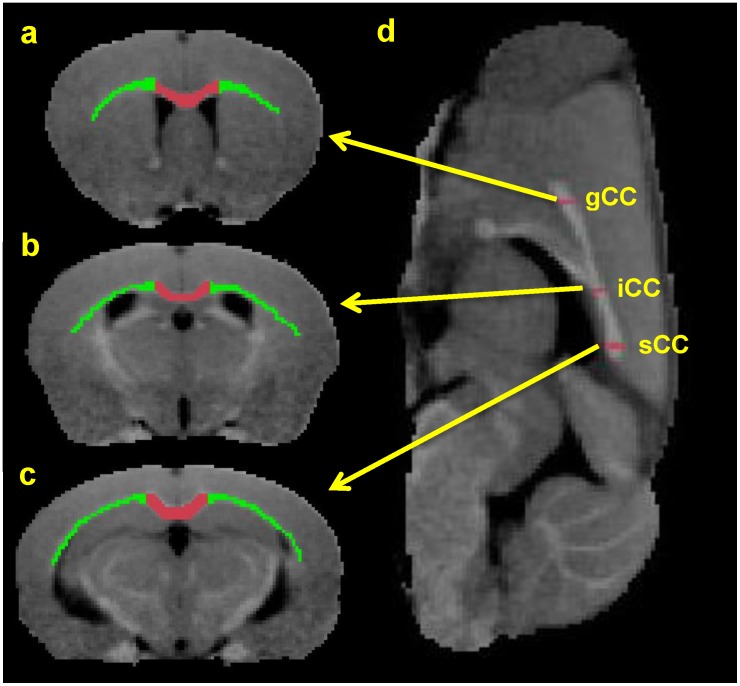
ROI Selection on Coronal MR Images.Colored ROIs used in scatter plots below are overlaid on population averaged baseline MTR images. Medial CC is red, lateral CC (including EC) is colored in green on coronal images. A sagittal view with arrows corresponding to the locations of the slices shown in (a-c), corresponding to genu (gCC), body/isthmus (iCC), and splenium (sCC), respectively, is shown in panel (d).